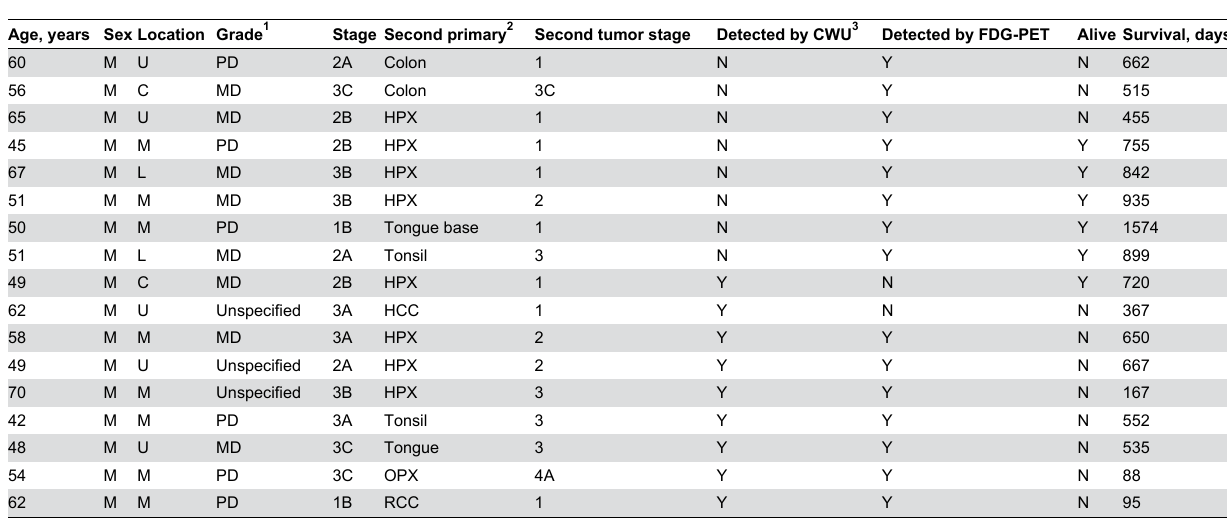
Age, years Sex Location Grade